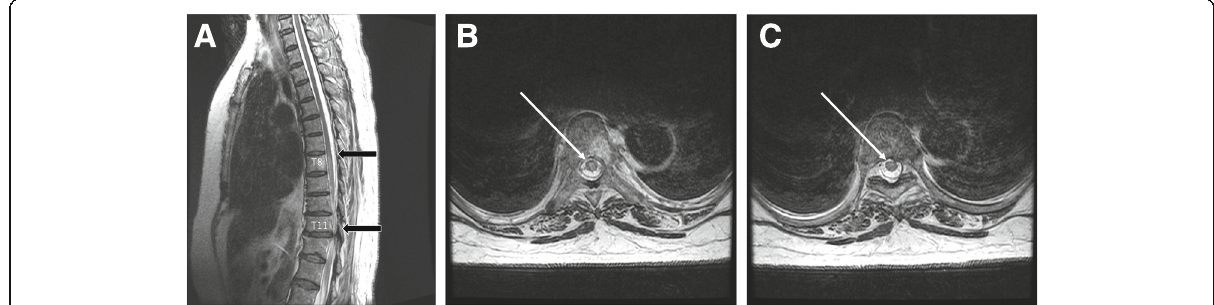
Fig. 1 a Sagittal magnetic resonance imaging (MRI) revealed hyperintensity in the thoracic cord from T8 to T11 ( arrows ); spinal cord infarction was suspected. b Axial MRI of the T8 spinal cord level. A hyperintense area was apparent ( white arrow ). c Axial MRI of the T6 spinal cord level. Normal intensity was observed ( white arrow